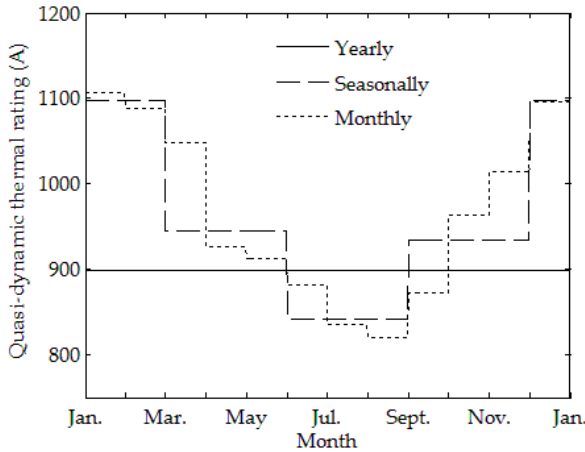
Figure 6. QDR under different time scales (99% confidence level). Table 2. QDR under different time scales (99% confidence level).